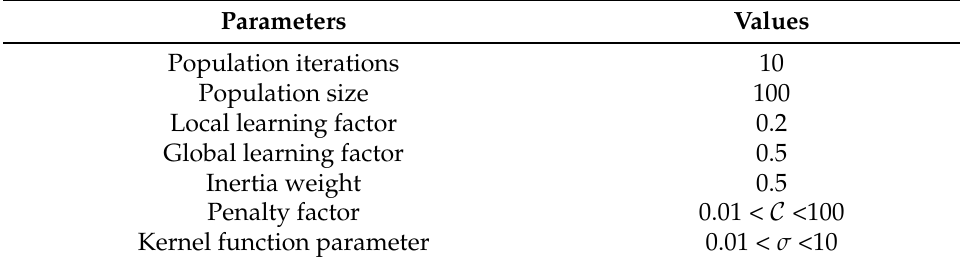
Table 4. SVM optimization parameters.